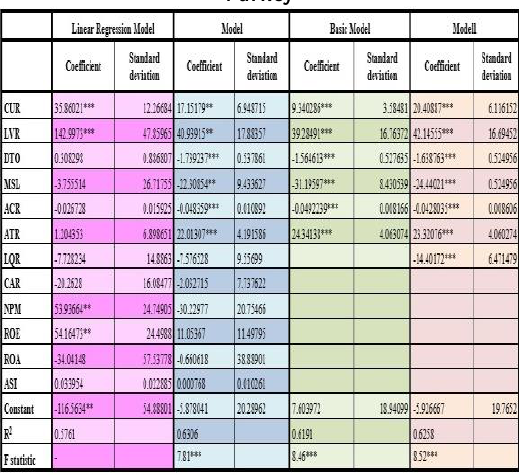
Table 8: Regression Models for Companies Traded